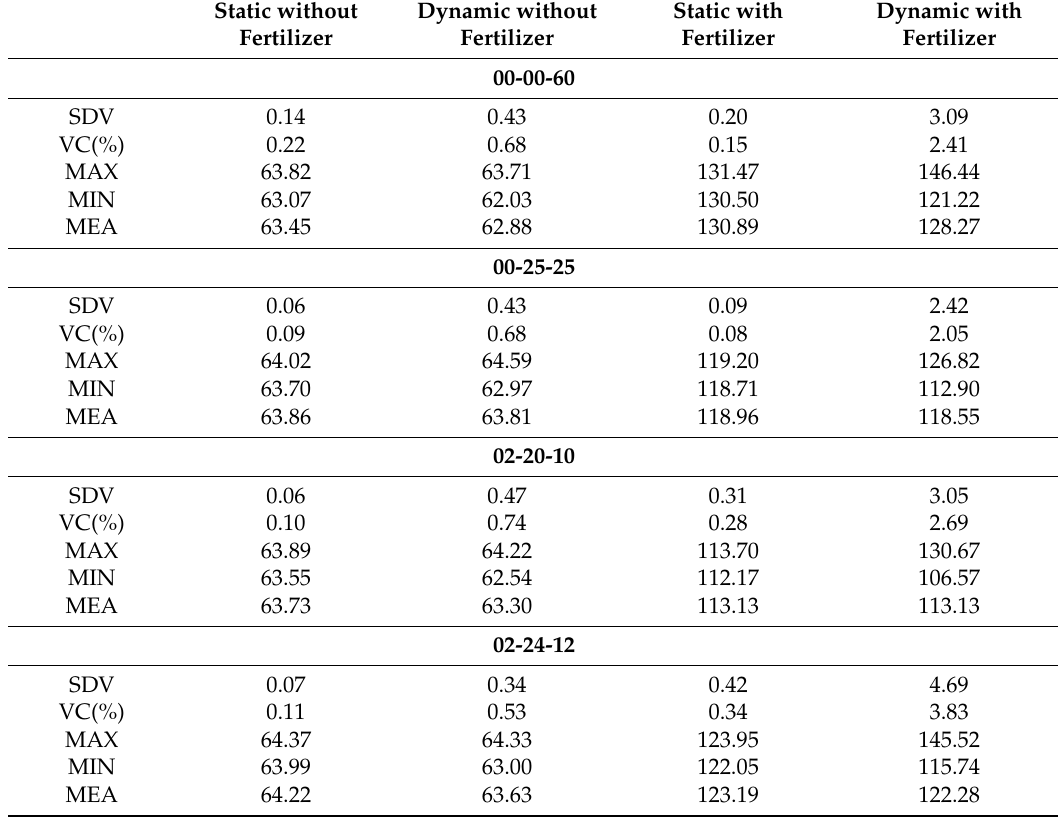
Table 3. Basic descriptive statistics of the sensor response with the overflow dosing